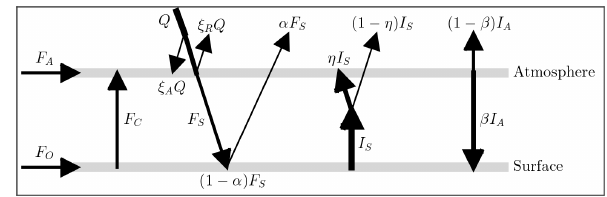
Figure 1. A visualization of the energy balance model. Symbols are defined in Table 1 and Sect.